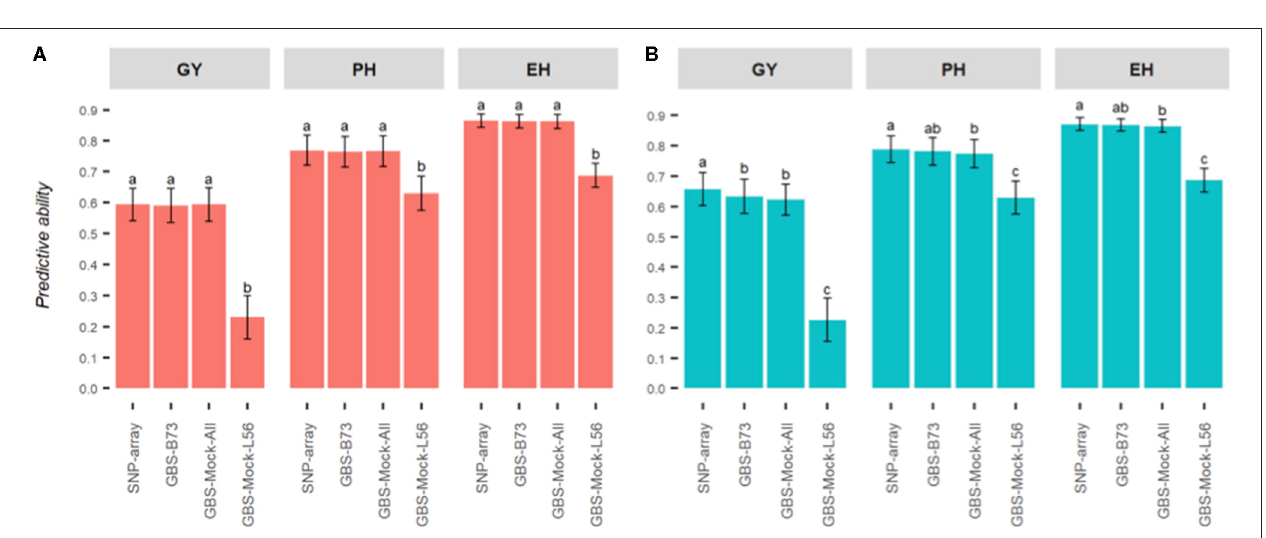
FIGURE 3 | Summary of the predictive abilities for each combination of model and genotyping scheme studied for three agronomic traits in maize (EH, ear height; PH, plant height; GY, grain